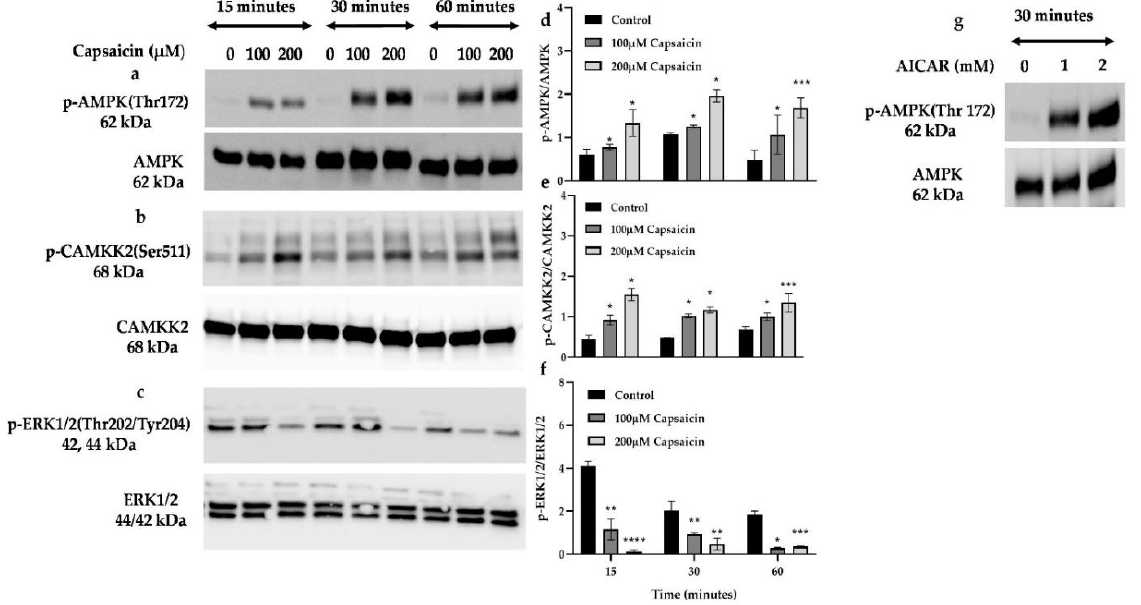
Figure 4. Western blot analysis of phosphorylated and total AMPK, CAMKK2, and ERK 1/2 in capsaicin treated mouse myotubes. ( a , b , d , e ) Densitometric analysis for the pAMPK/AMPK and pCAMKK2/CAMKK2 over 60 min. ( c,f ) Repre- sentative Western blot and densitometric analysis for the ERK1/2 in the absence or presence of capsaicin over 60 min. ( g ) Immunoblots of p-AMPK and AMPK protein expression in the AICAR treated myotubes after 30 min incubation. Data are presented as mean ± SD of three independent repeats ( n = 3). * p < 0.05, ** p < 0.01, *** p < 0.001, and **** p < 0.0001 indicate a significant difference between capsaicin-treated and control groups.